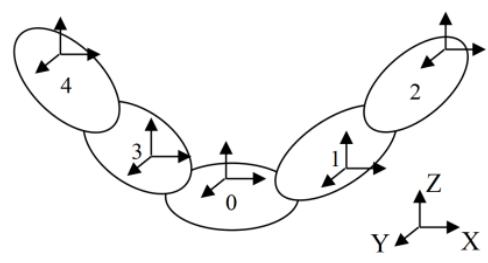
Figure 18. Topological structure diagram.